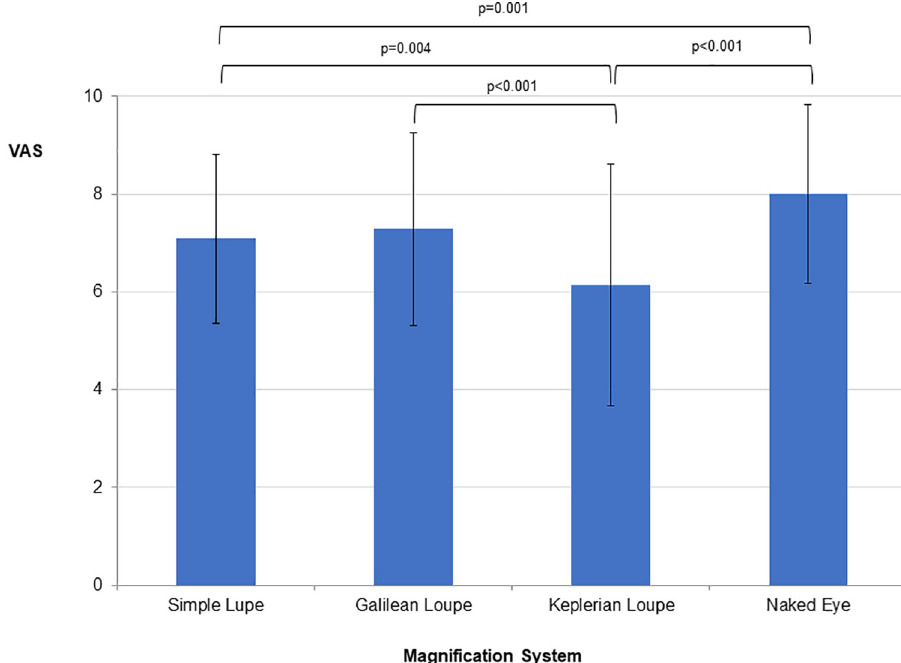
Fig 3. Mean, standard deviation, and summary of repeated measures Anova for the final perceived fine motor skills scores as measured on a VAS and organized by magnification system. Repeated measures ANOVA: SS = 160.162; df = 2.457; MS = 65.183; F = 16.345; p < 0.01; η p 2 = 0.152; π = 1.00. Horizontal lines indicate statistically significant difference between means according to the Bonferroni post-hoc